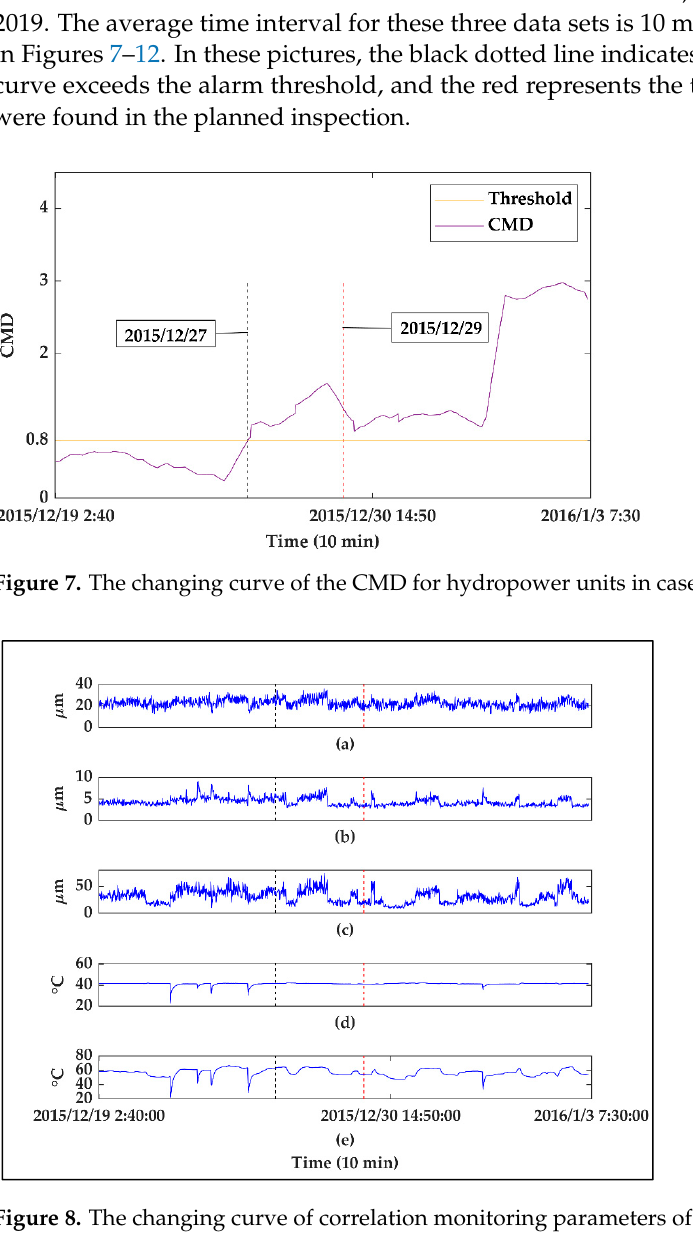
Figure 9. The changing curve of the CMD for hydropower units in case 2.